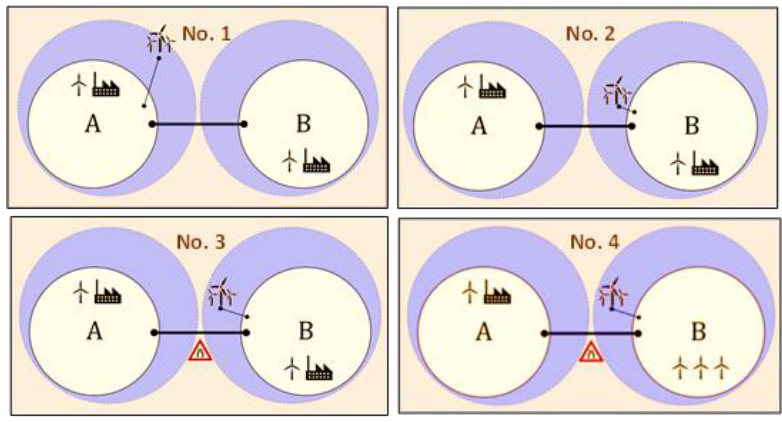
Figure 15. Scenarios of cross-border cooperation in wind energy. Source [67].